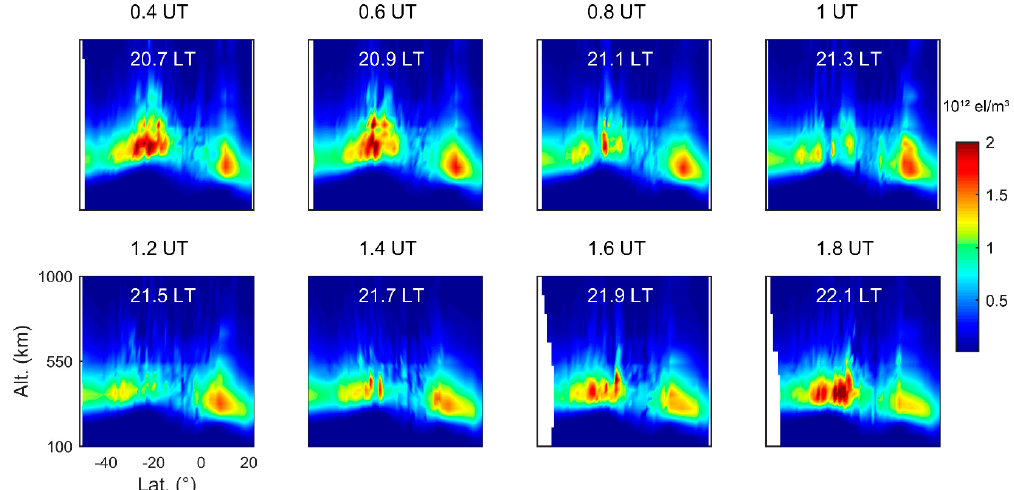
Figure 11. Reconstructed ionospheric profiles during the propagation of an ionospheric plasma bubble over the longitudinal sector of 55°W.